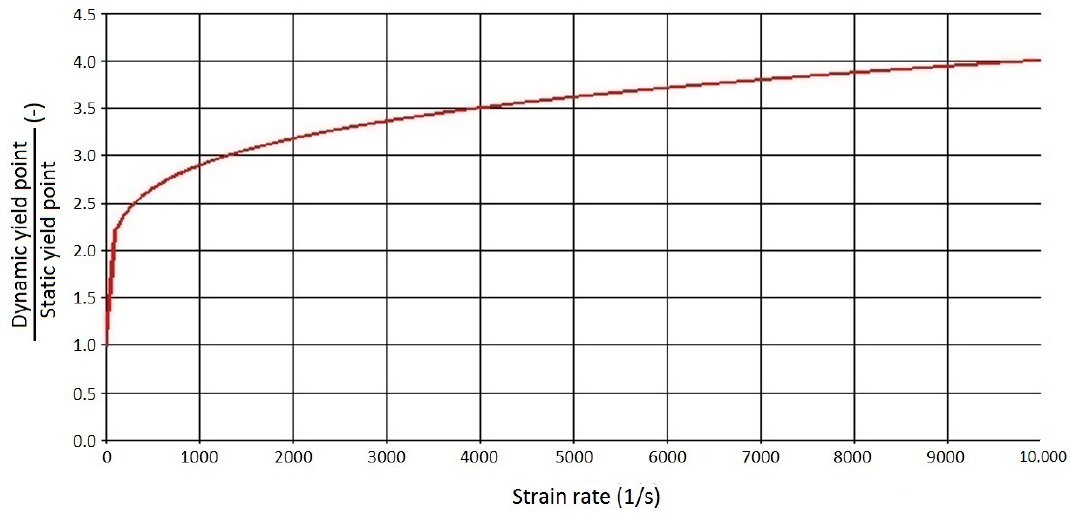
Figure 4. Influence of the strain rate on the dynamic yield point.